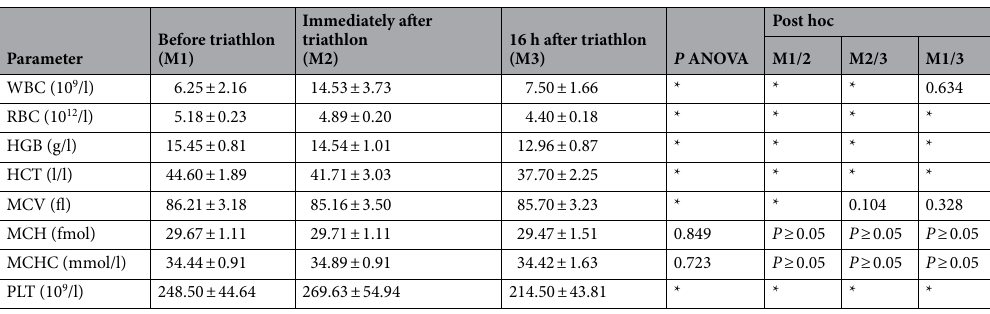
Table 2. Mean values (± SD) of blood morphology indicators in the 3 performed measurements (M). *Significant difference ( P < 0.05). WBC white blood cells count, RBC red blood cells count, HGB haemoglobin,